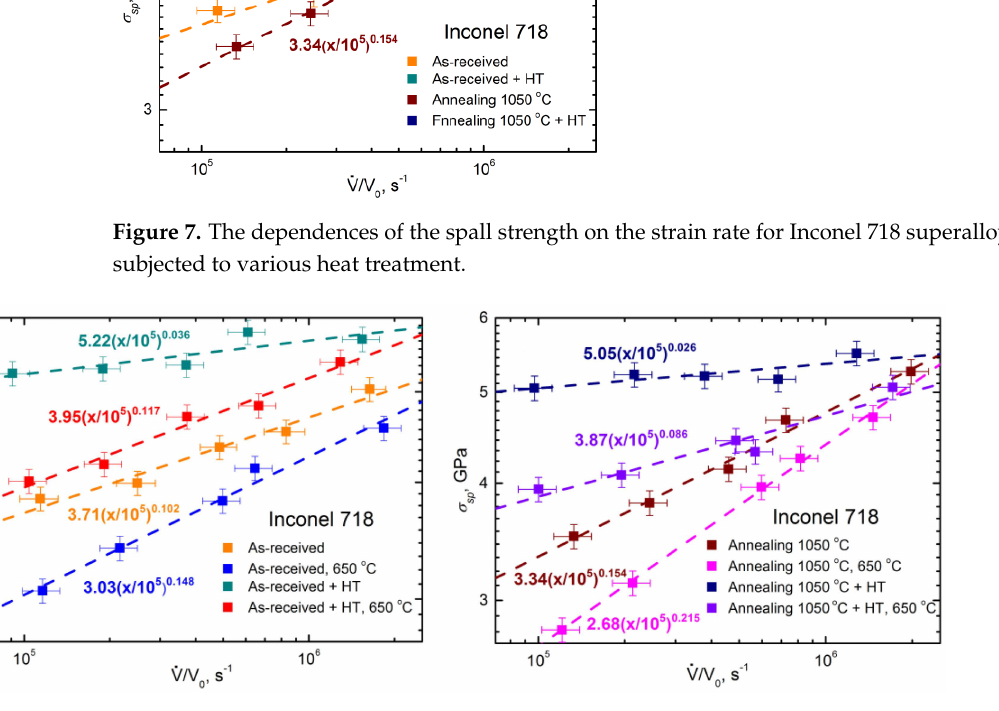
Figure 8. The effect of temperature on the spall strength of Inconel 718 superalloy samples subjected to various heat